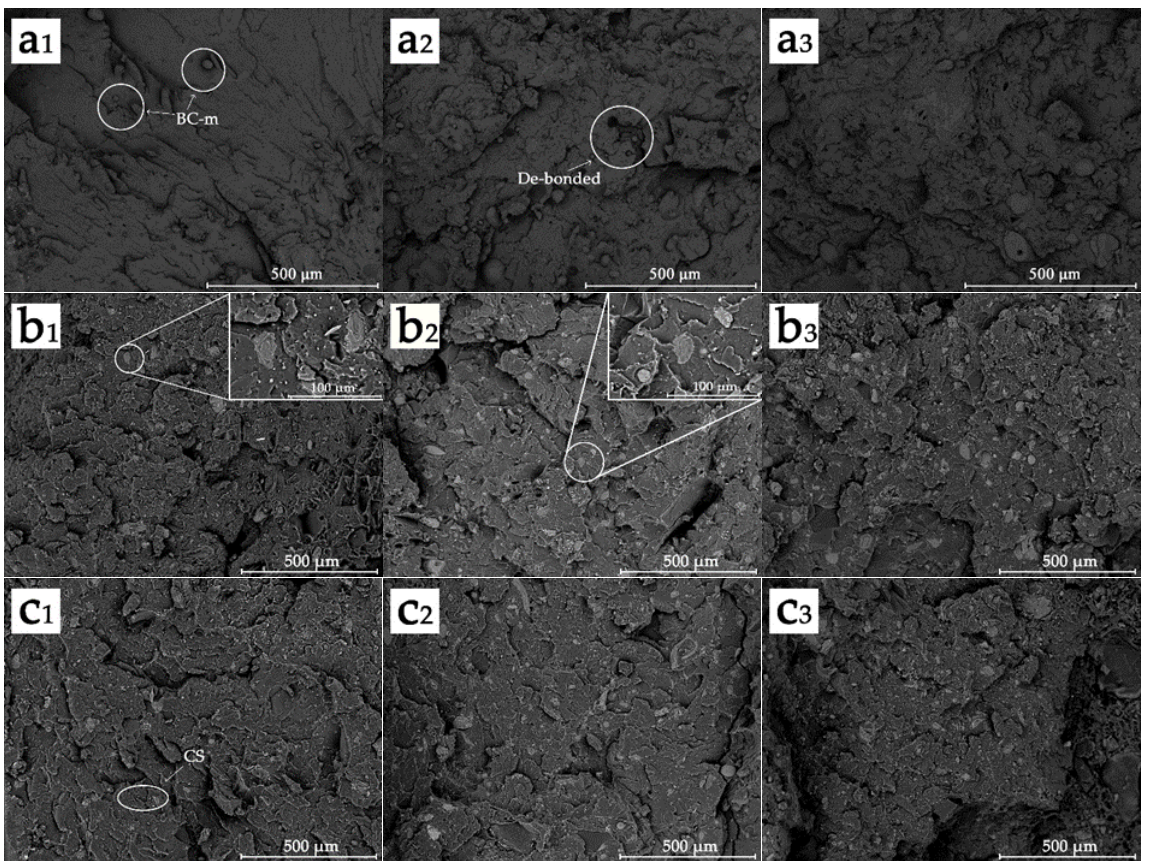
Figure 3. SEM images of fracture surface morphology: ( a 1 ) FPLA-B1, ( a 2 ) FPLA-B2, ( a 3 ) FPLA-B3, ( b 1 ) FPLA-C31, ( b 2 ) FPLA-C32, ( b 3 ) FPLA-C33, ( c 1 ) FPLA-C51, ( c 2 ) FPLA-C52, and ( c 3 ) FPLA-C53.